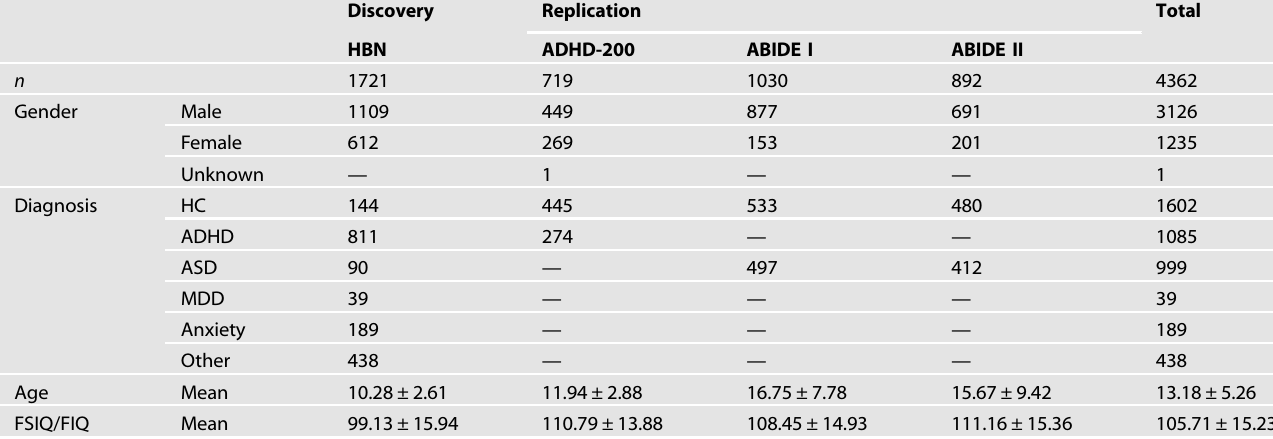
Table 1. Discovery and replication